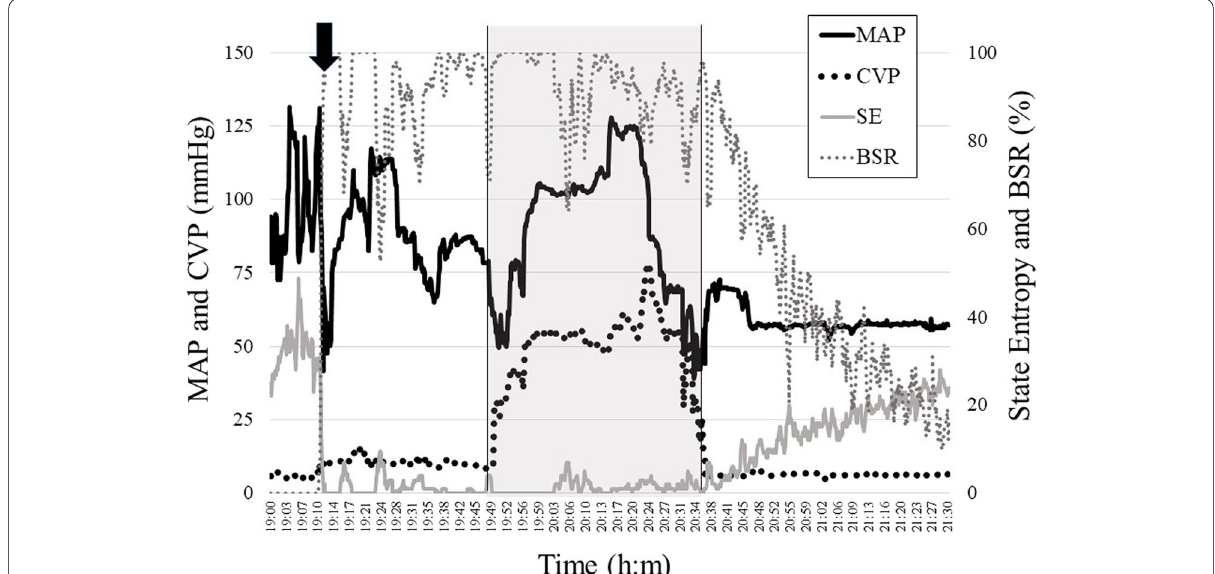
Fig. 1 Changes in hemodynamics, state entropy, and BSR. The black line indicates the mean atrial pressure (MAP). The black dotted line represents the central venous pressure (CVP). The gray line indicates the state entropy. The gray dotted line represents the burst suppression ratio (BSR). The black arrow indicates the administration of thiopental. The gray area indicates the time during which cerebral congestion occurred. The entropy value increased gradually after the release of cerebral